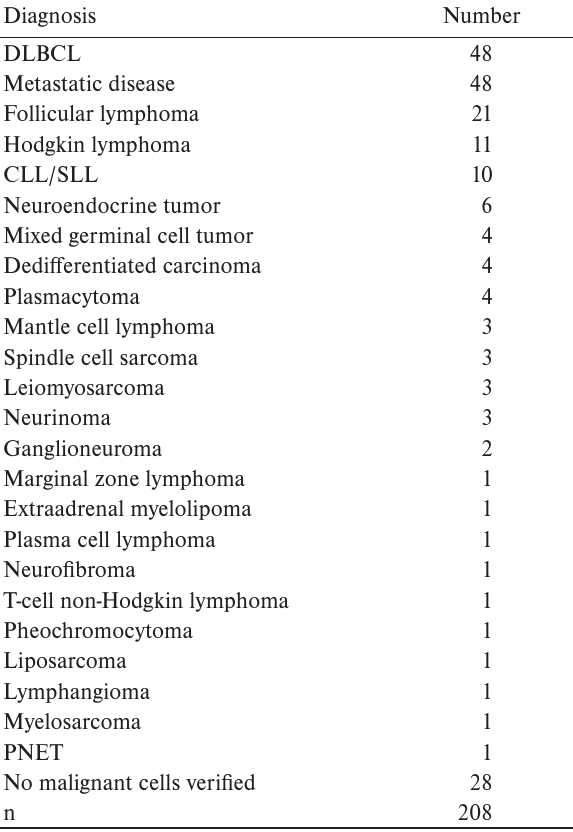
Table 1. The number of verified diagnoses.